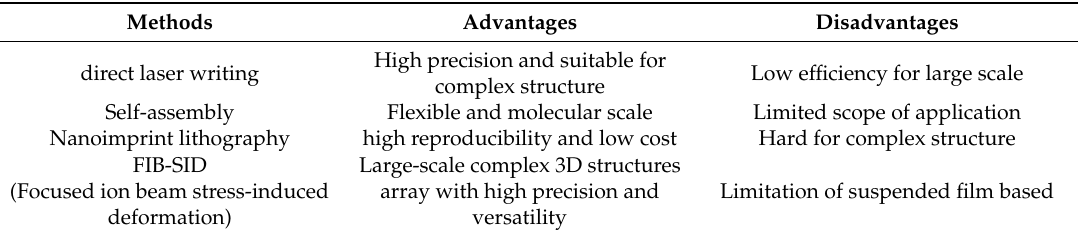
Table 1. Comparison of the four micro / nanofabrication fabrication methods for 3D